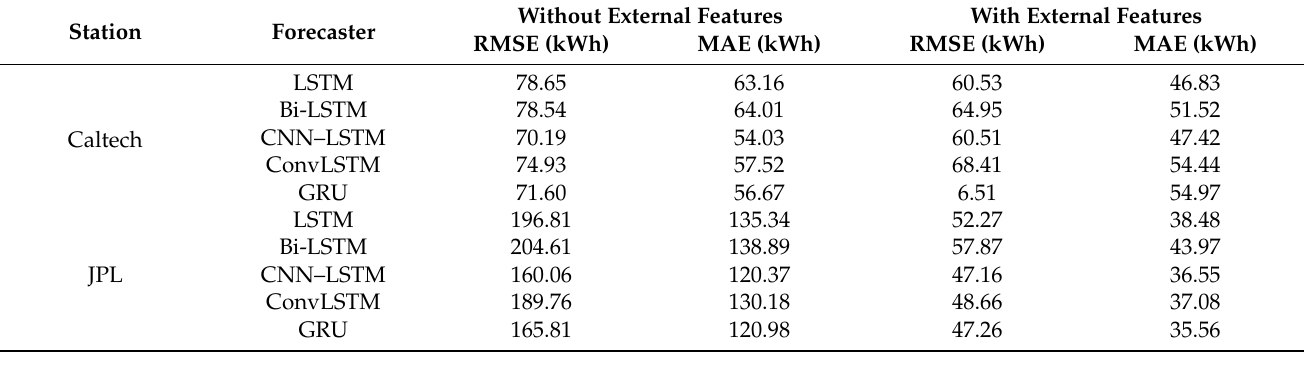
Table 7. Effect of external feature in forecasting.